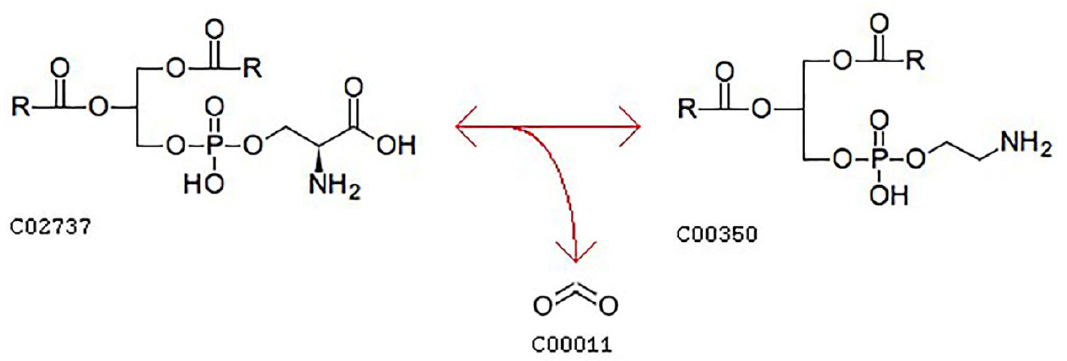
Figure 16. ( a ) Pathway analyses of differential lipids in three camellia oils using three refining methods. ( b ) glycerophospholipid metabolism.